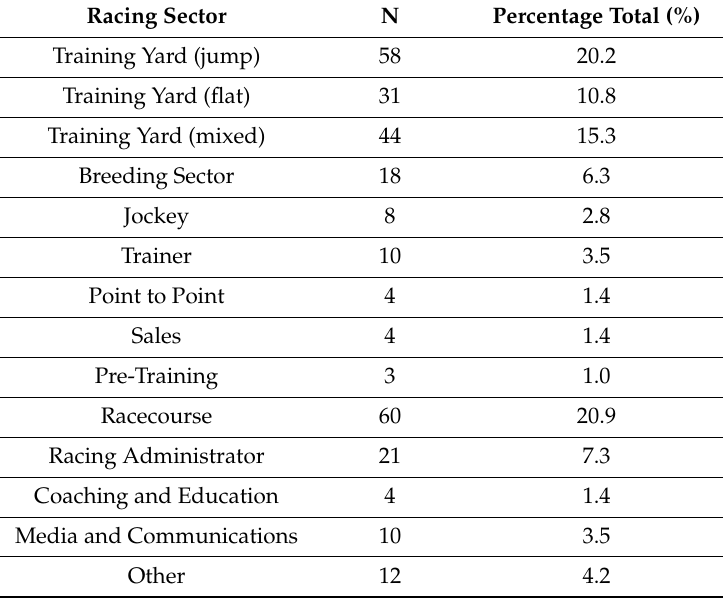
Table 1. Sta ff working in di ff erent sectors of the racing